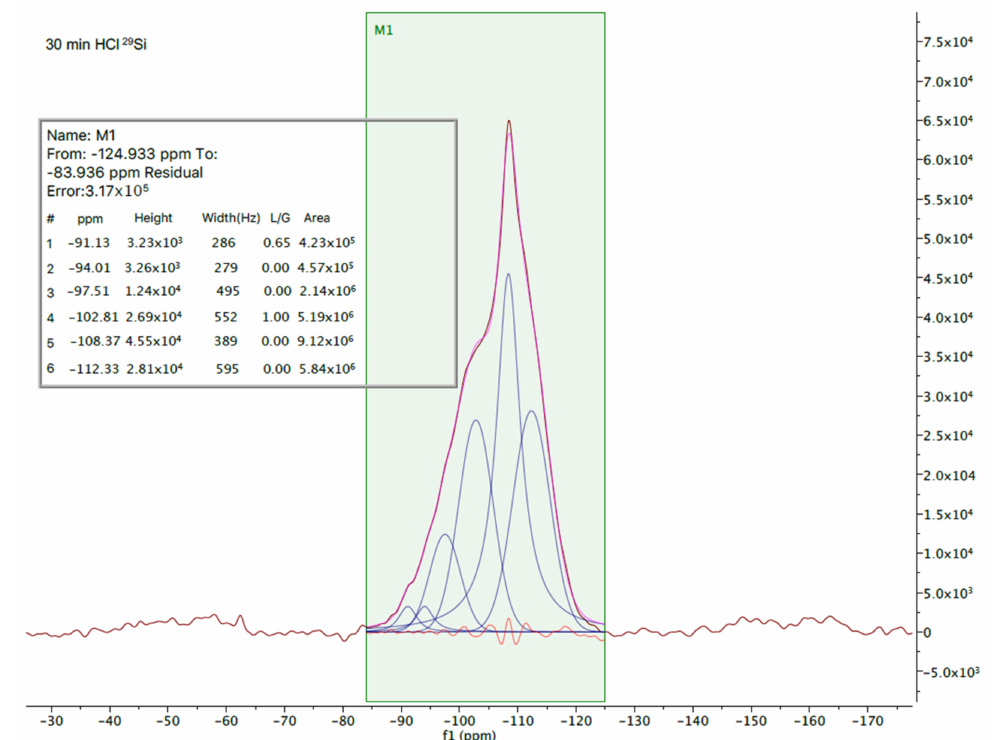
Figure 12. The 29 Si NMR spectrum of 30 min HCl NV-Na referenced externally to a sample of talc at − 98.1 ppm relative to TMS at 0 ppm. The resonances on top are from the sample, and the deconvoluted components of the fit are